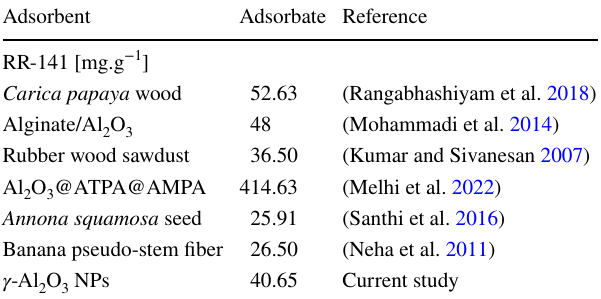
Table 7 Comparison of Langmuir adsorption capacities of RR-141 with results from previous